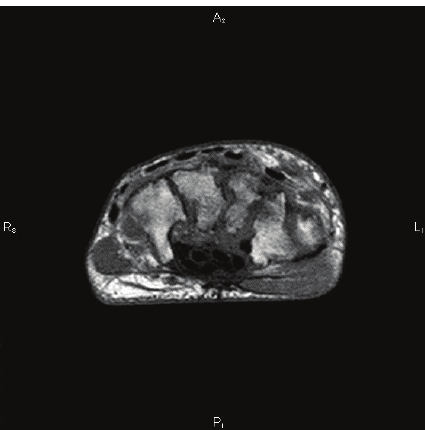
Figure 2: Magnetic resonance imaging of the left wrist after three months of specific antibiotic therapy versus Brucella spp. and Mycobacterium bovis . The picture shows slight decrease of signal intensity of trabecular bone of radium and carpal bone and mod- erate reduction of edema extension in scaphoid and capitate